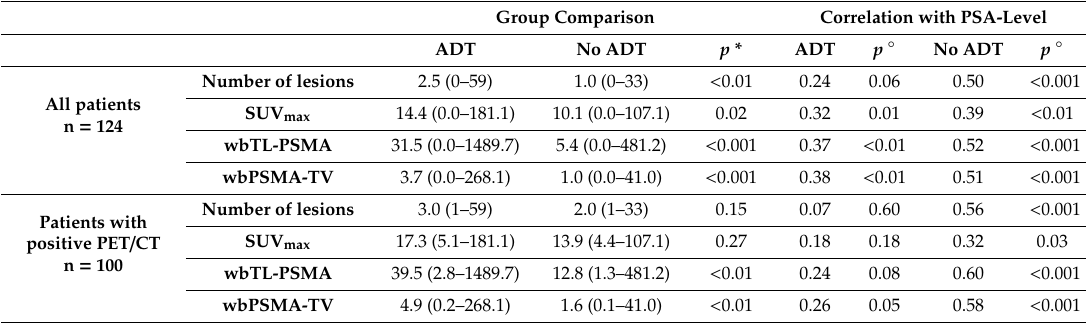
Table 4. Group comparison and correlational analysis of quantitative parameters in patients with and without ADT. Group Comparison Correlation with PSA-Level